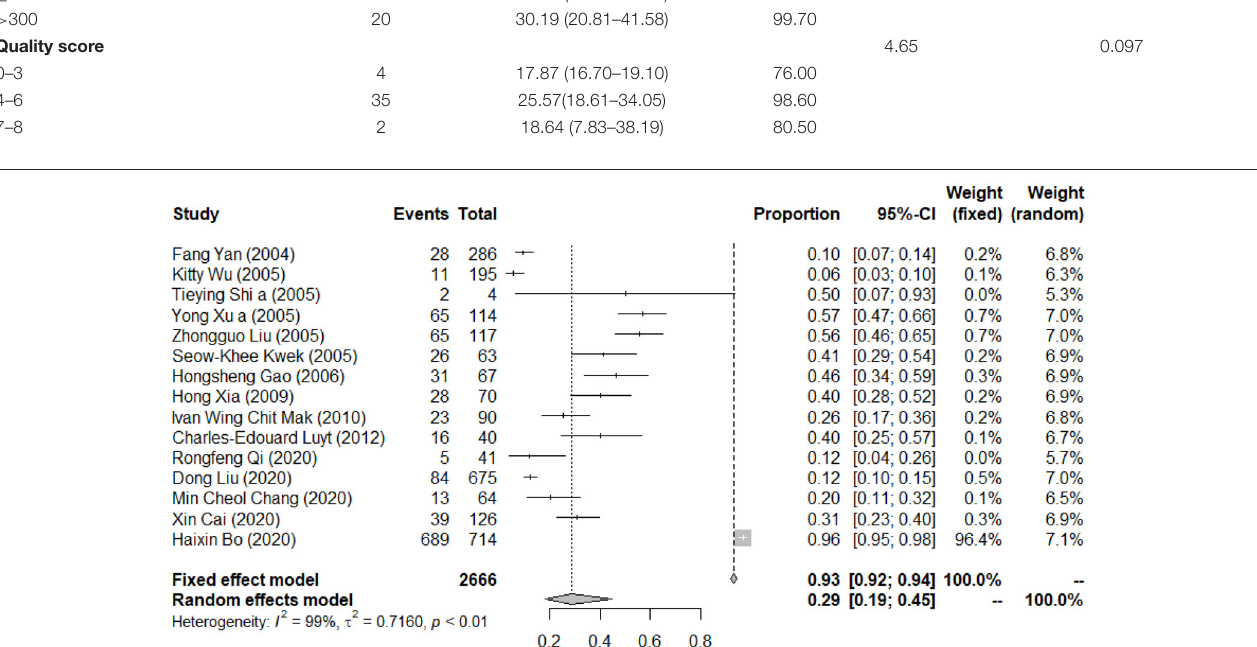
FIGURE 4 | Forest plots of pooled prevalence of post-traumatic stress symptoms among patients with infectious disease.